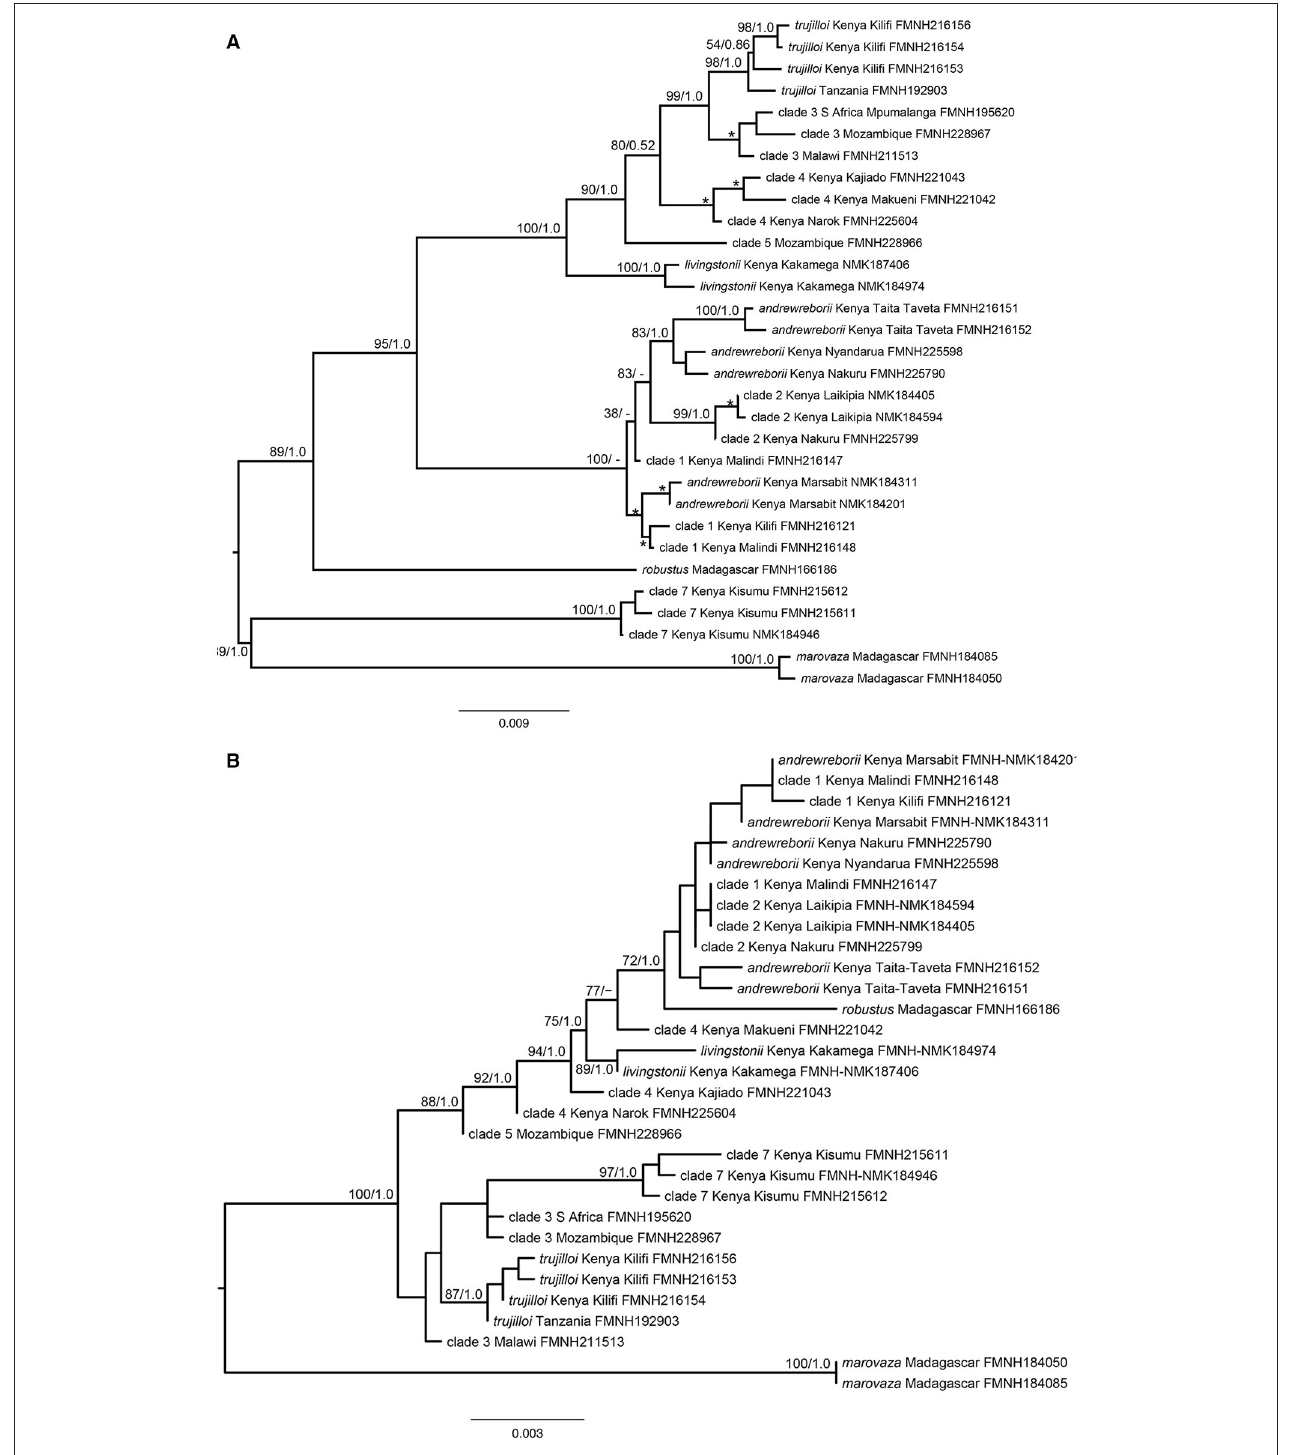
FIGURE 2 | (A) Concatenated maximum likelihood phylogeny of mitochondrial cytochrome b and six nuclear introns of Scotophilus and, (B) Concatenated maximum likelihood phylogeny of six nuclear introns of Scotophilus . Maximum likelihood bootstrap support (BP; left) and Bayesian posterior probability (PP; right) are represented above branches. Minor nodes with BP ≥ 70% and PP ≥ 95% are indicated by *.